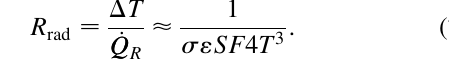
FIG. 1. (Color) Ideal measurement